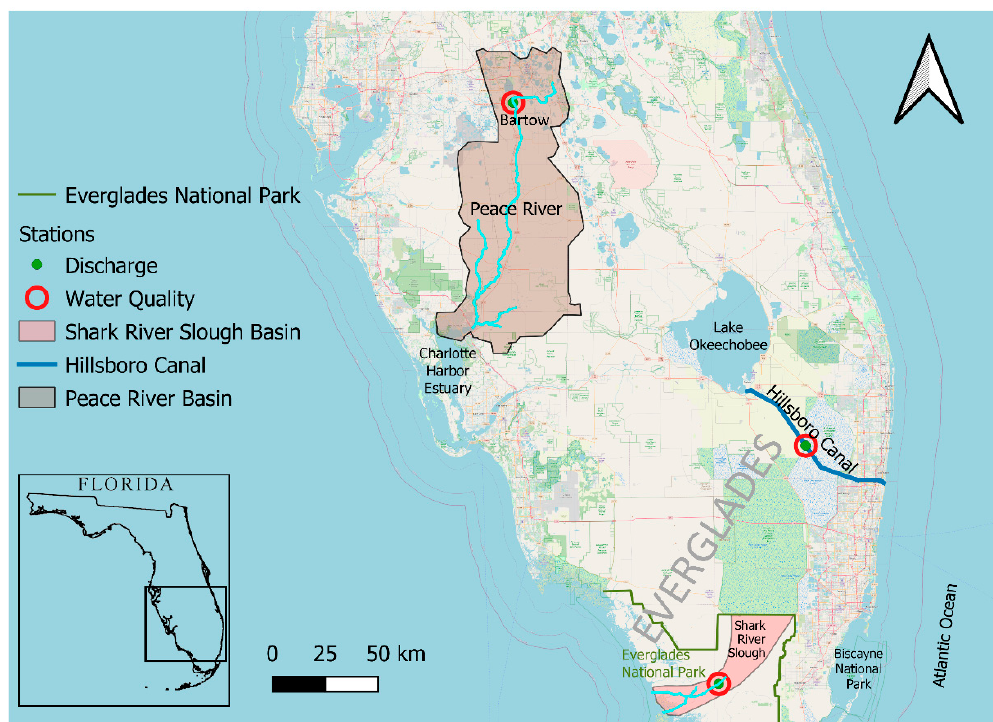
Figure 2. Locations of study sites: Shark River Slough, Peace River, and Hillsboro Canal.